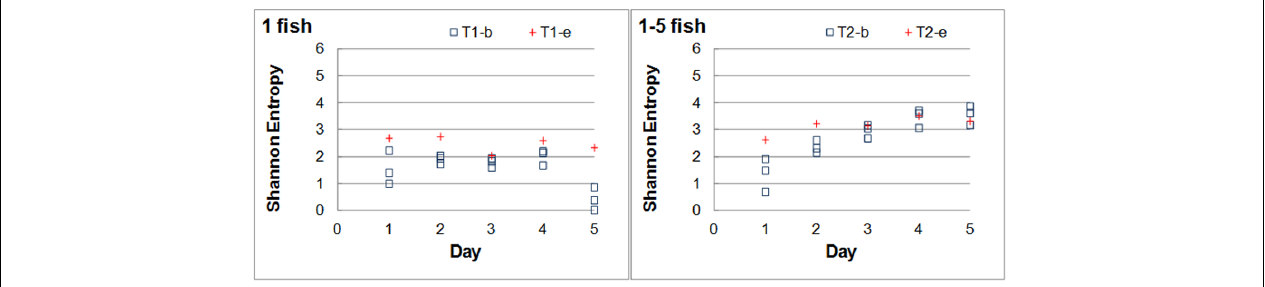
previously established corrective actions. Since it is desirable